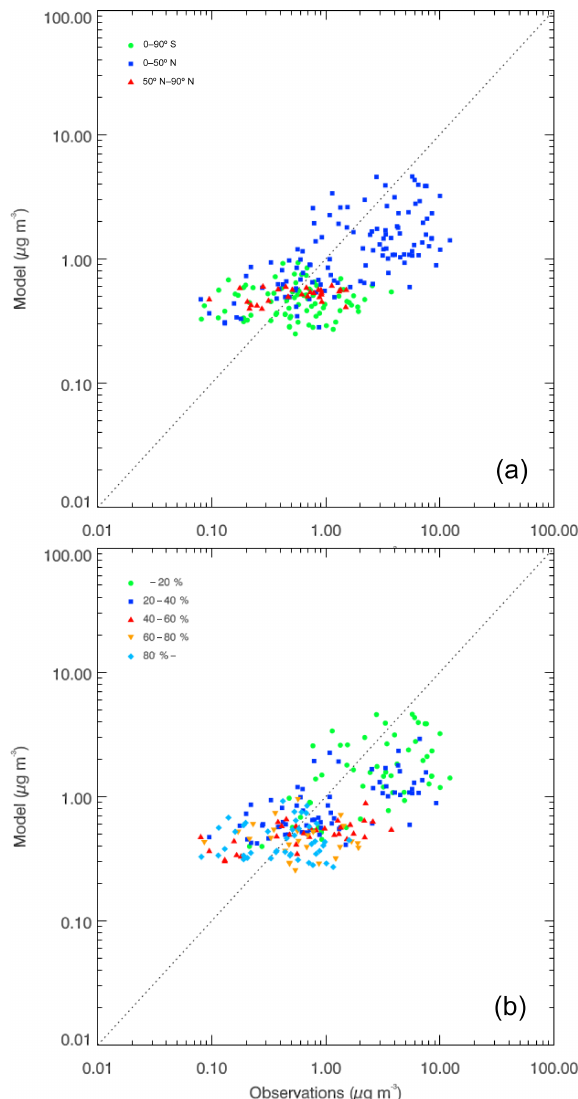
Figure 3. Correlation between observed and modelled nss-SO 2 − using the control run (L10 & N00 & γ a ). Modelled nss-SO 2 − derived from mean results of the simulation during the time period from 2004 to 2008. Observed concentrations are from 1995 to 2012 and matched to the nearest grid point and month of the model re- sults. Comparison is done for (a) different latitude bands and (b) dif- ferent fractions of sulfate that is produced by DMS emissions.